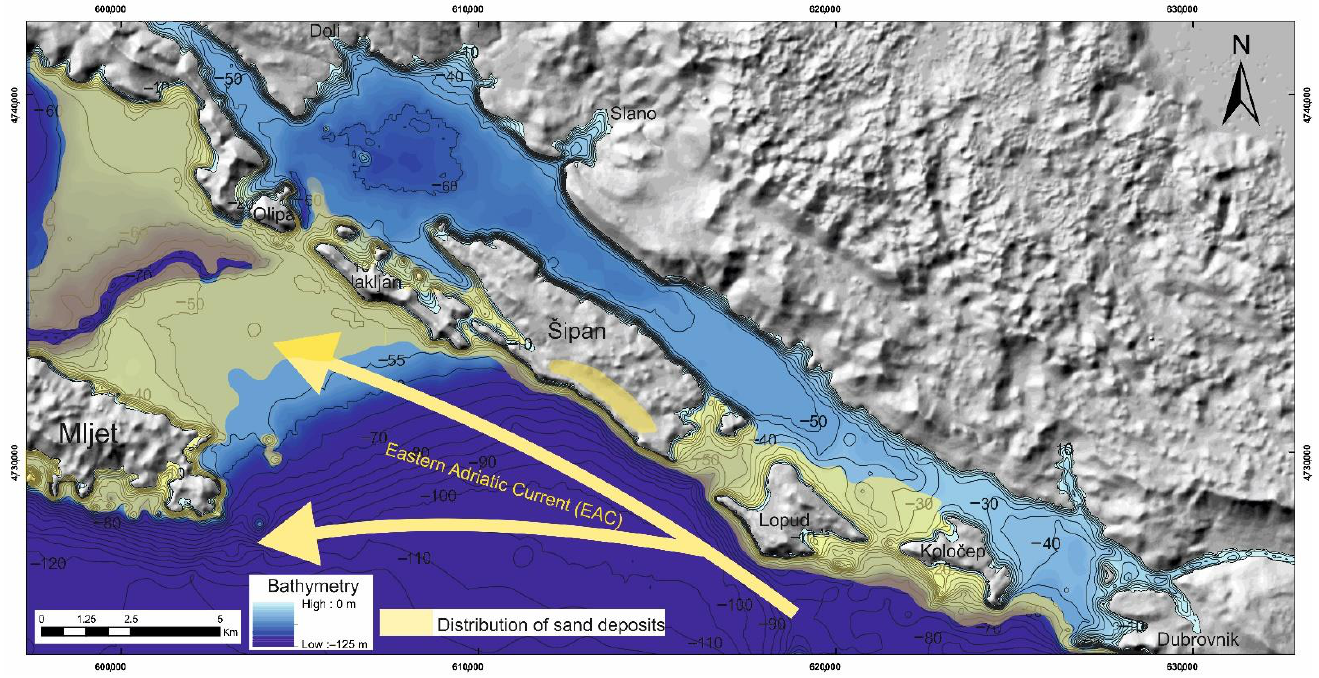
Figure 7. Bathymetric map based on the surface of seismostratigraphic sequence S.S.S.1. combined with the legacy bathymetric data, generally following the −55 m contour in the bay. The sand deposits are based on the legacy bathymetric map, data [61,62], and the SBP survey.